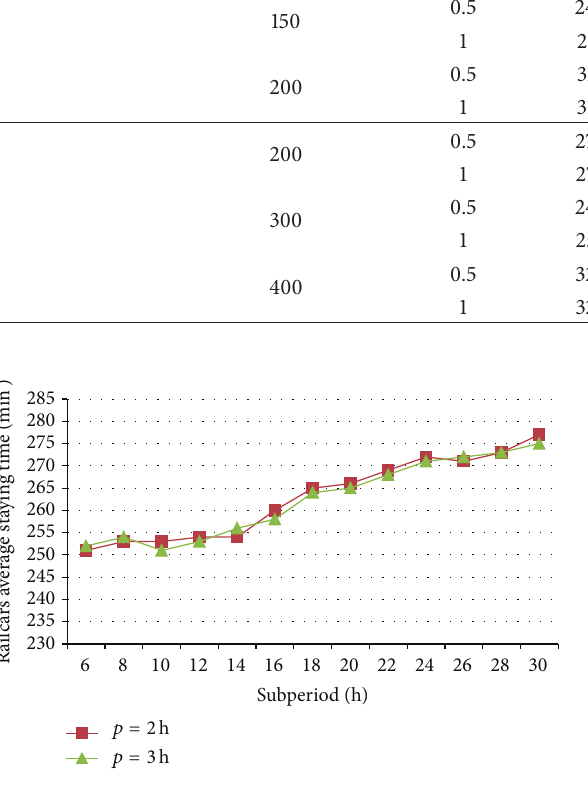
Figure 10: Railcars average staying time of different subperiod and overlap lengths.